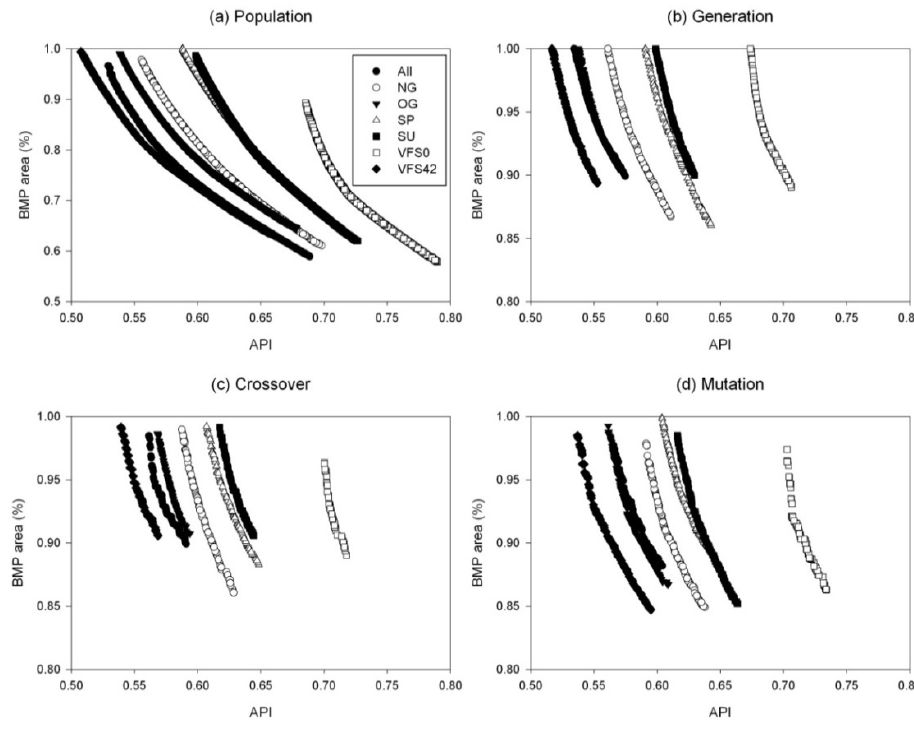
Figure 5. Comparison of the Pareto-optimal fronts for models with different BMP options using their optimal GA